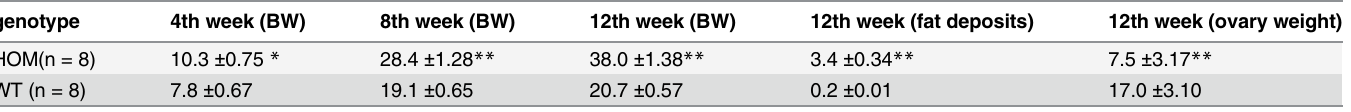
Table 2. Body weight (BW), abdominal fat deposits and ovarian weight in HOM and WT groups (mean ± SD, g for BW and fat deposits, mg for ovary weight).